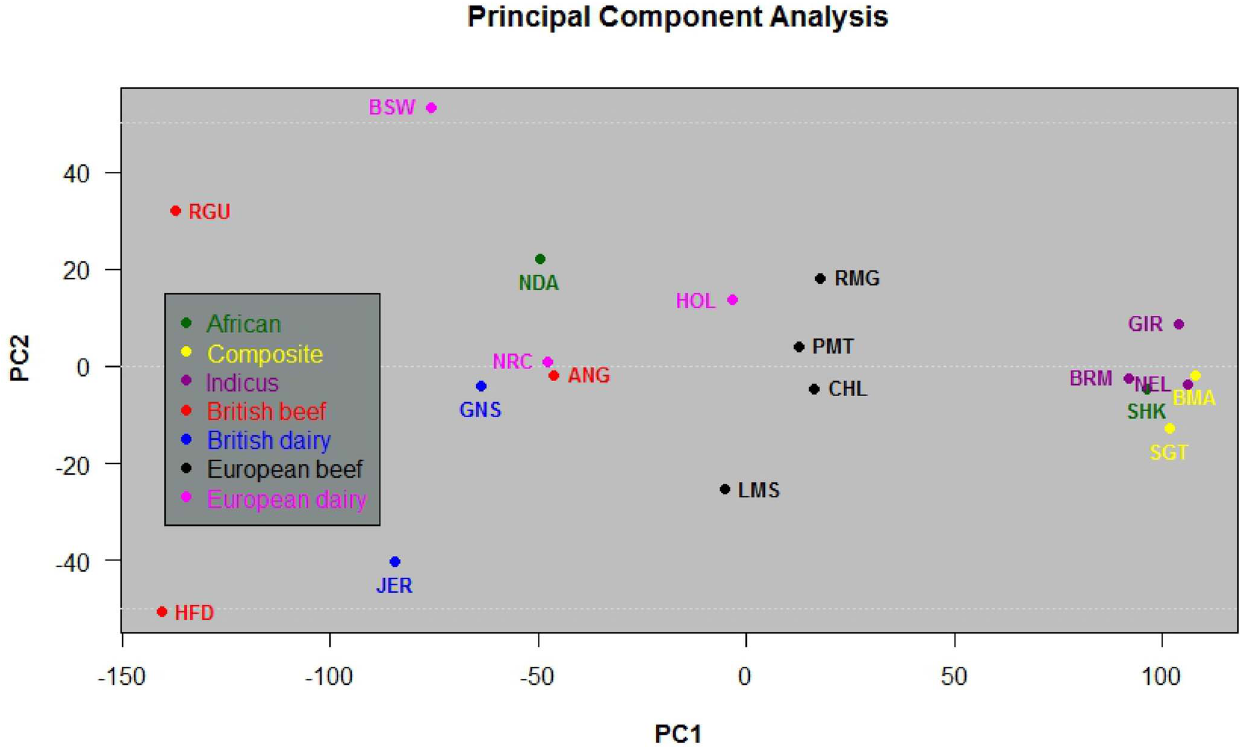
Figure 5. Principal Component Analysis of structural variation statistics. PCA of the number of structural variations found per chromosome per breed.